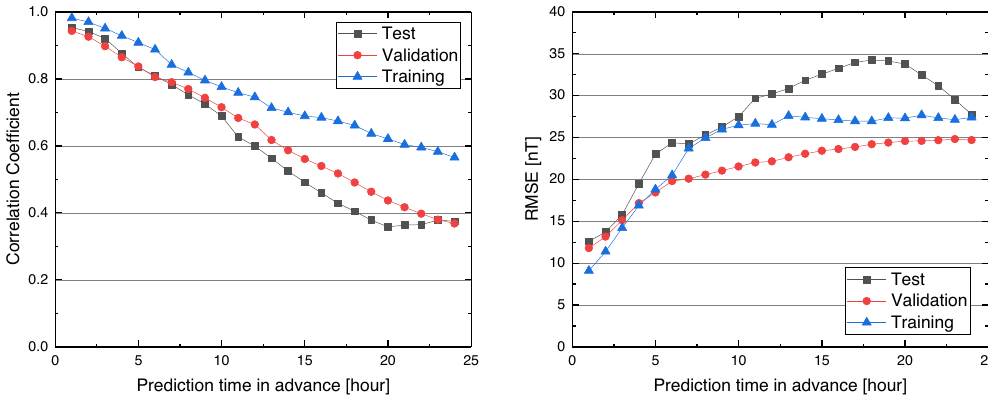
Fig. 8. KDP model ’ s performance for training, validation, and test